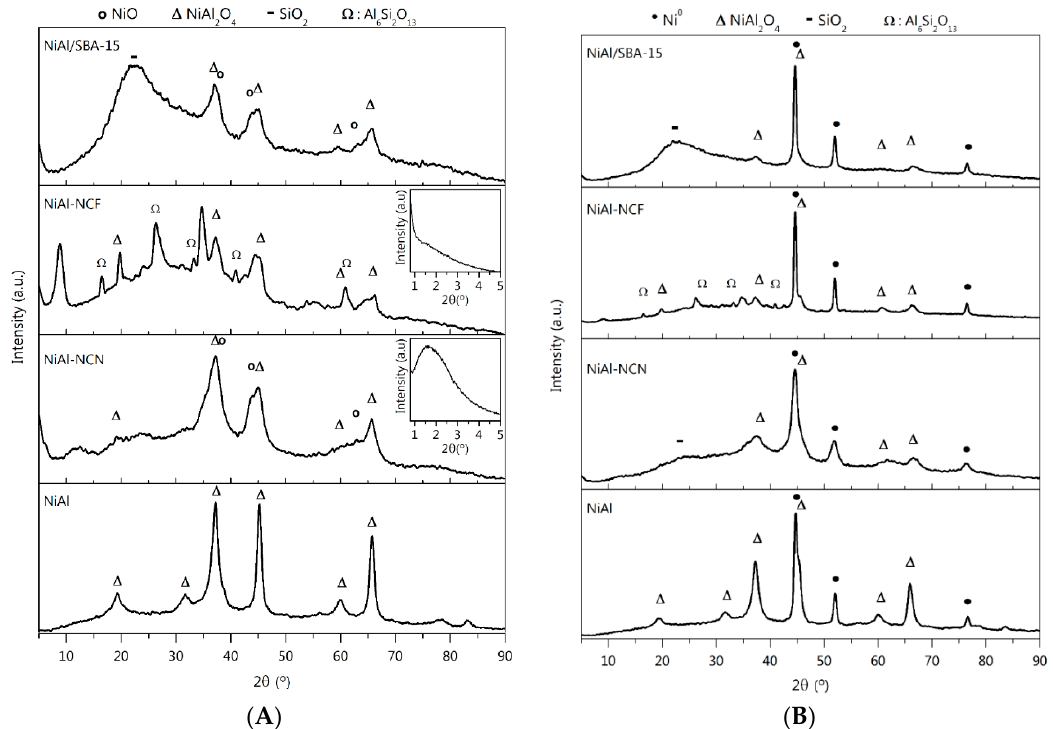
Figure 3. XRD diffractograms for the ( A ) calcined and ( B ) reduced forms of the solids. Insets include small ‐ angle RXD patterns.